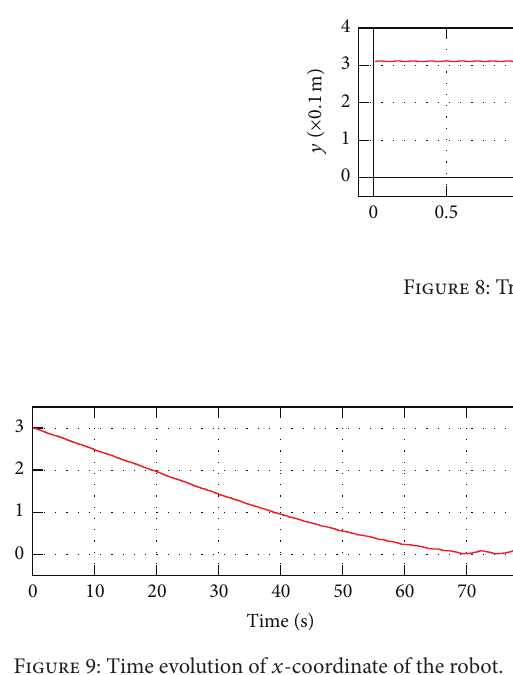
Figure 9: Time evolution of 𝑥 -coordinate of the robot.